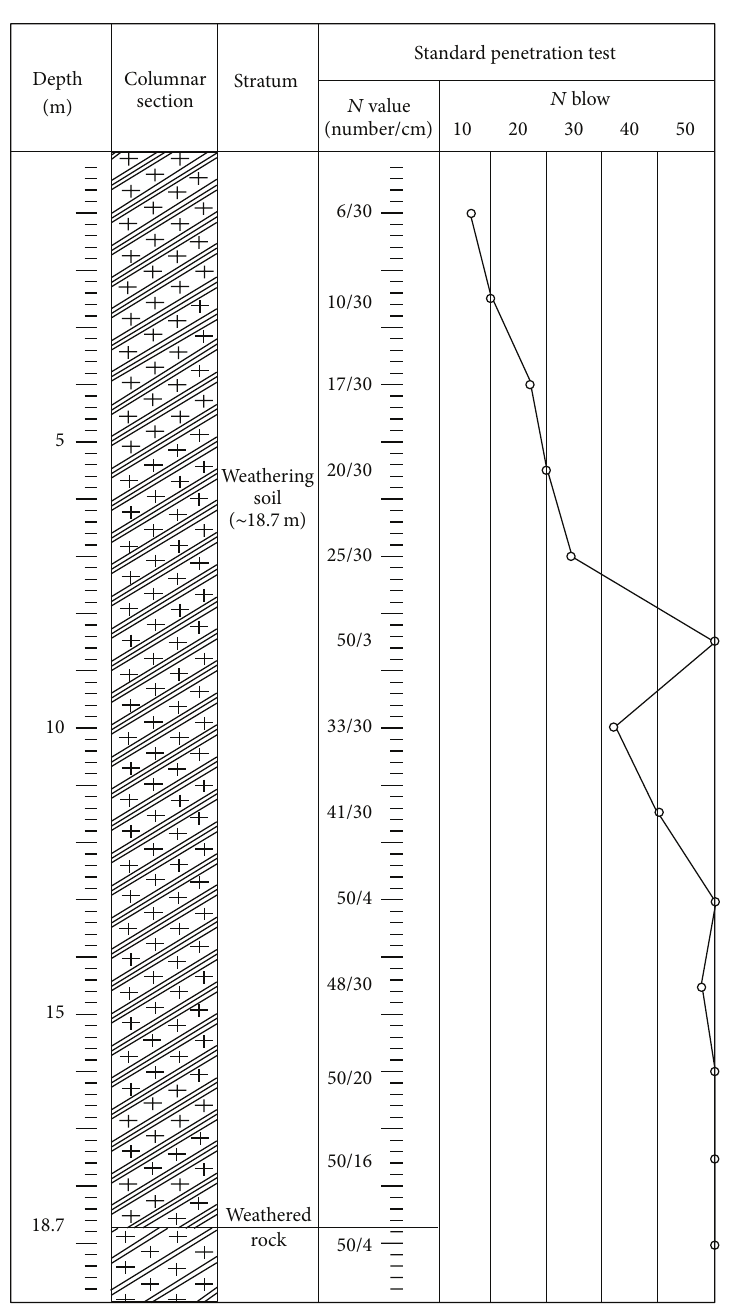
Figure 2: Soil profile sample of the construction site at which the experiment is applied.